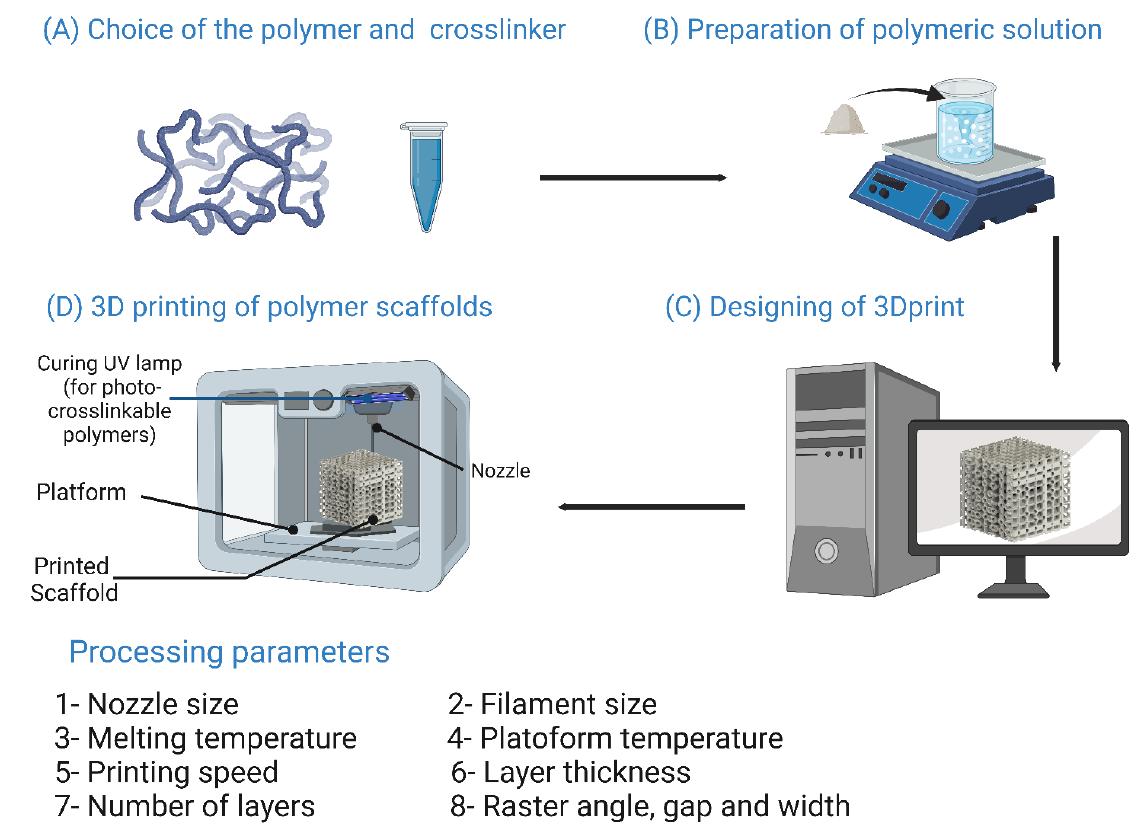
Figure 16. The 3D printing technique and its processing parameters and additives. The image was created using Biorender.